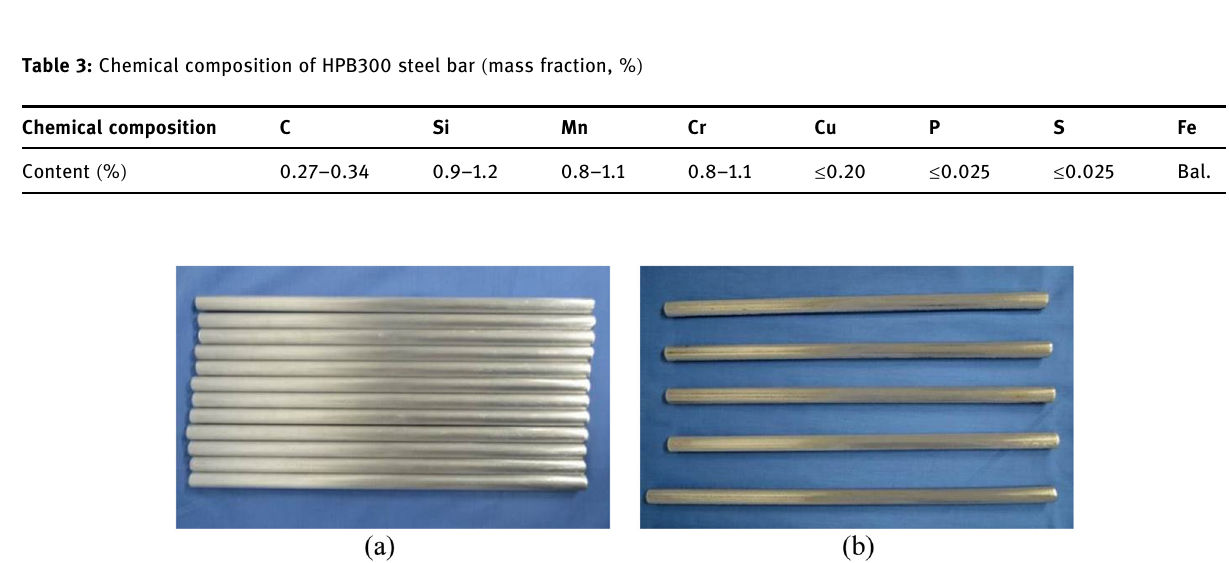
Chemical composition